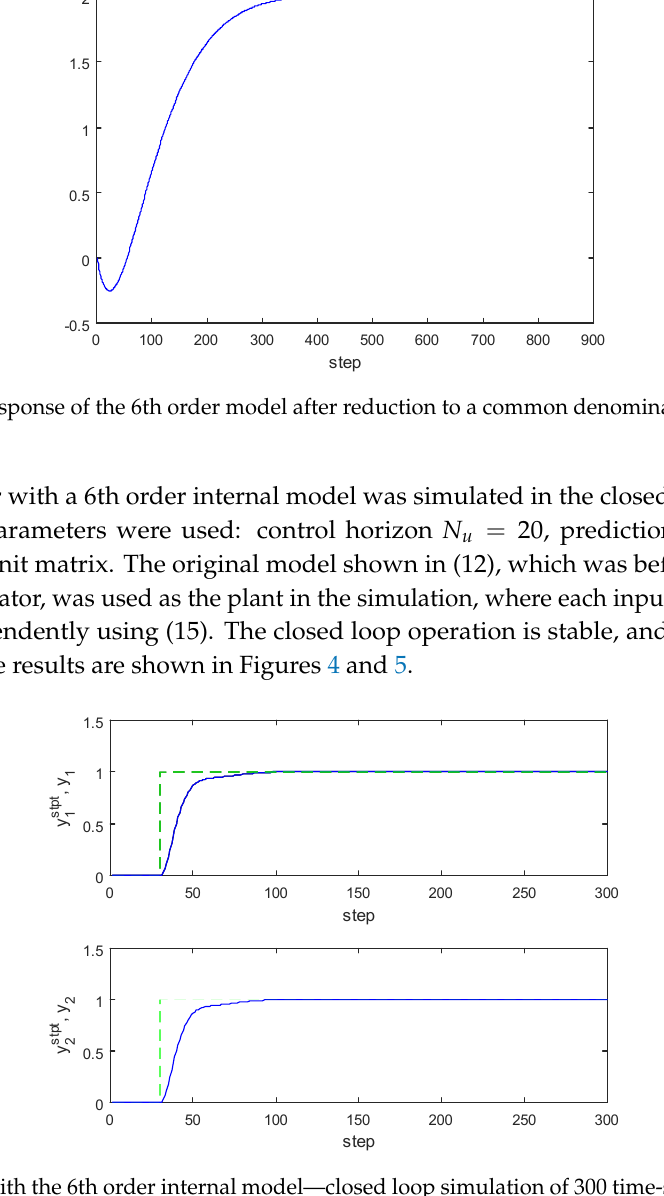
Figure 4. GPC with the 6th order internal model—closed loop simulation of 300 time-steps, dashed line is the set point, and the solid line is the CV.